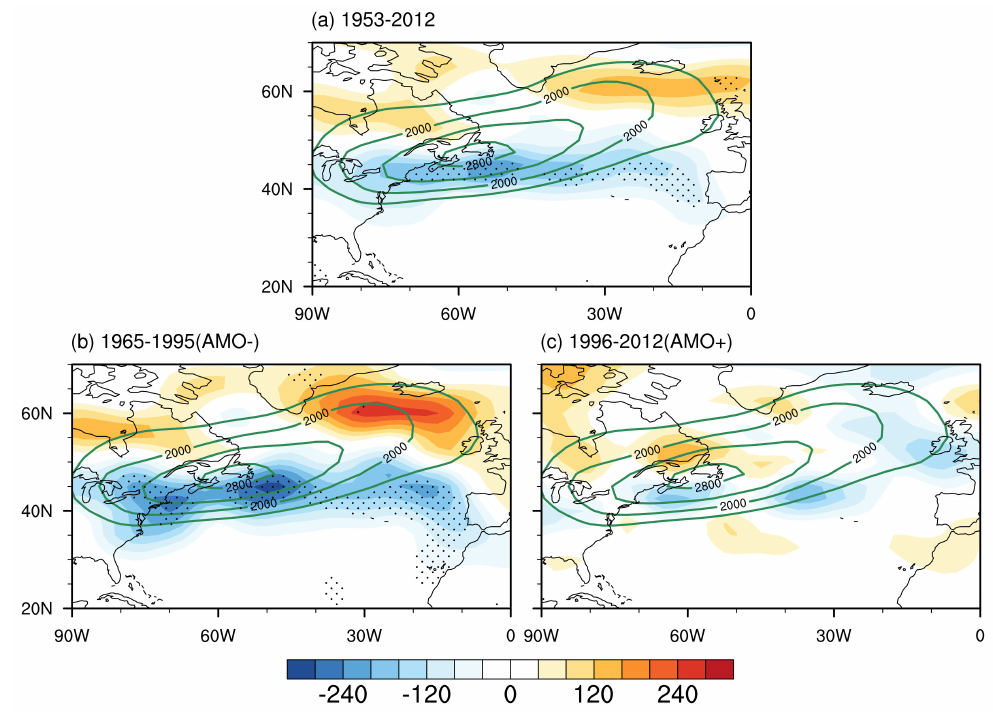
Figure 5. Regression coefficients of 500-hPa band-pass-filtered geopotential height variance Z (cid:48) 2 (shading; units: m 2 ) onto the Niño3.4 index in spring during: ( a ) 1953–2012; ( b ) 1965–1995 (AMO − ); and ( c ) 1996–2012 (AMO+). Stippling represents significance exceeding the 95% confidence level. The green contours represent the spring climatological